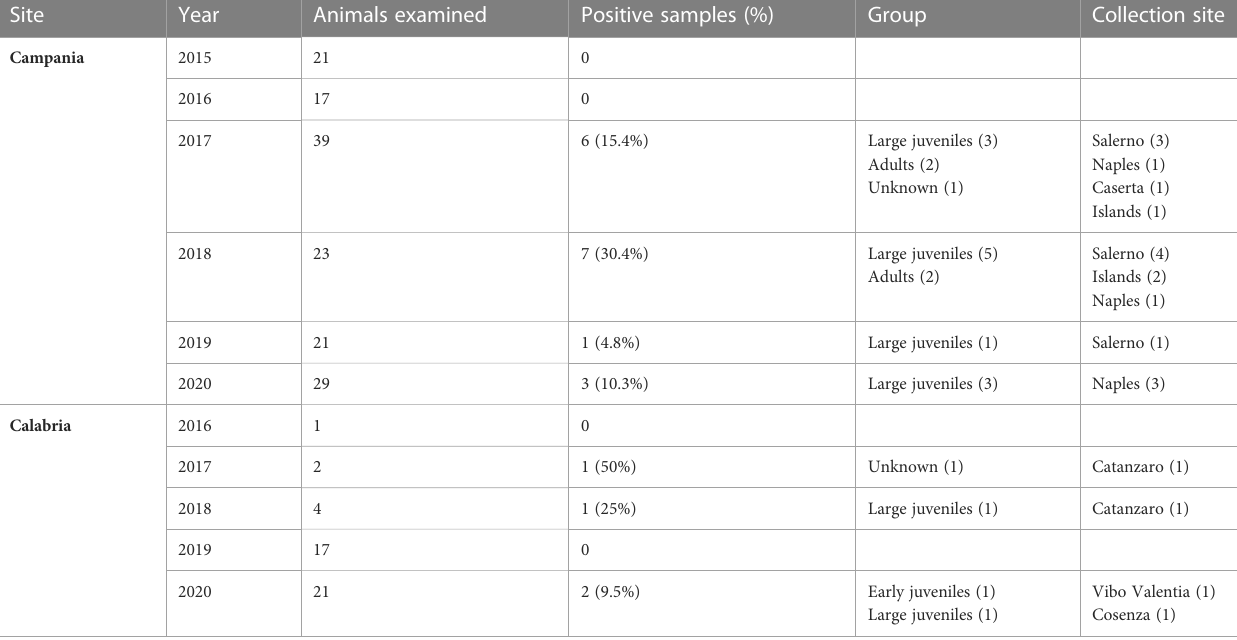
TABLE 4 Sea turtles examined from 2015 to 2020, the prevalence of positivity to ChHV5, age group, and collection sites of positive turtles. Site